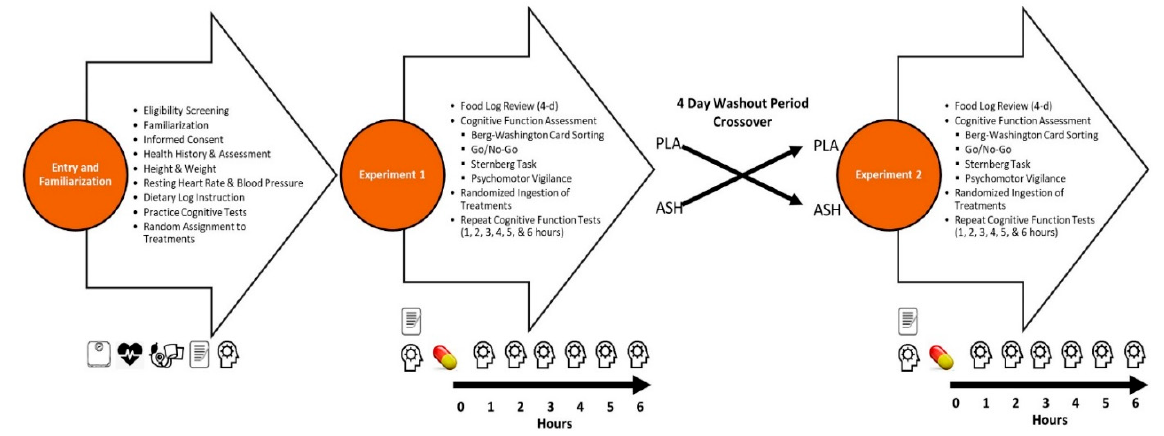
Figure 2. Experiment timeline.